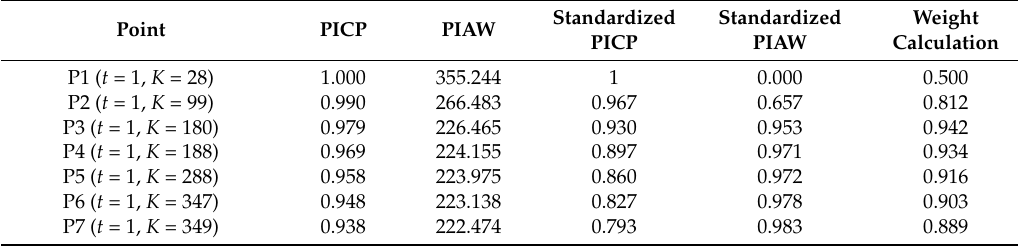
Table 2. Weight calculation results of the points in the Pareto optimal solutions set in region 2.